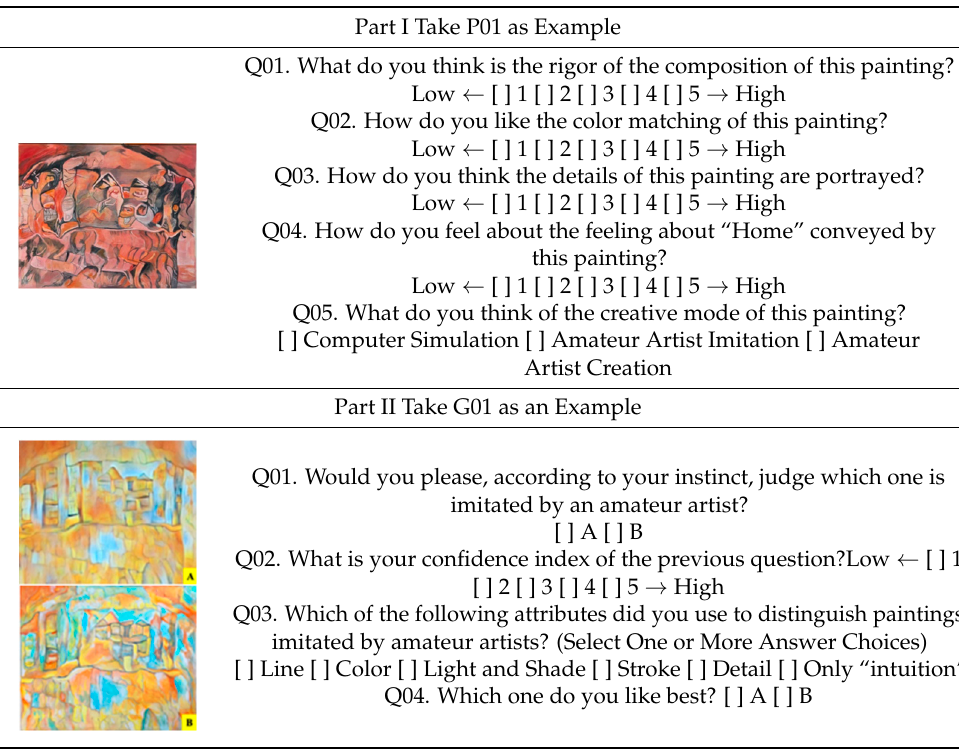
Table A1. Example of the stimulus assessment section of the questionnaire.